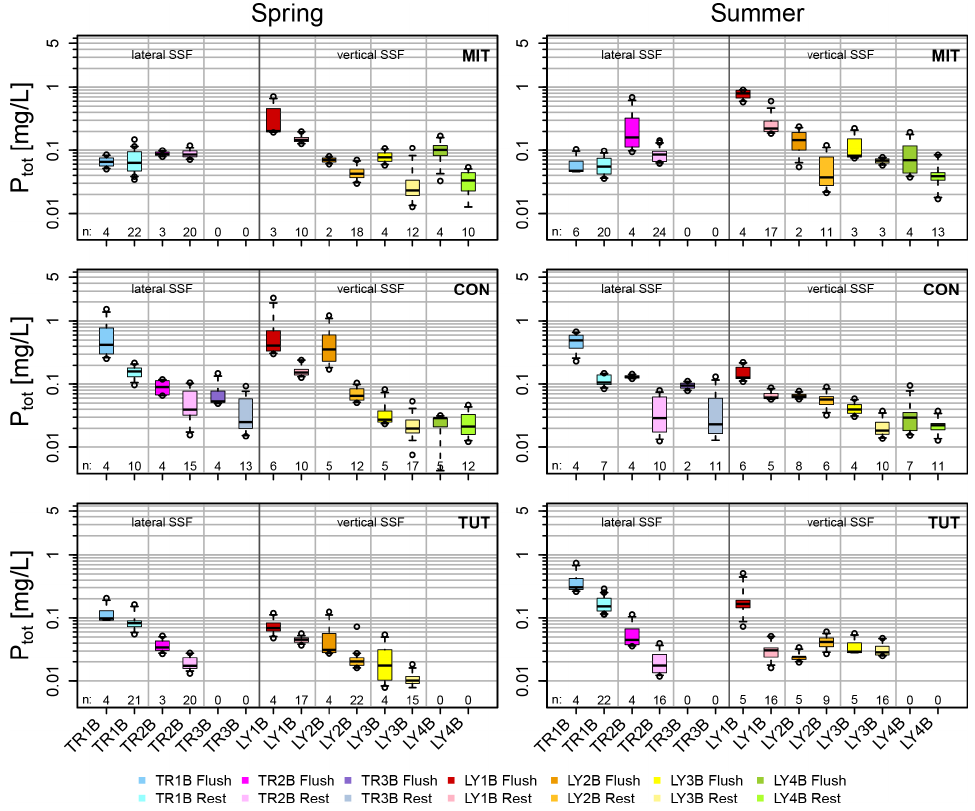
Figure 5. P tot concentrations of vertical and lateral subsurface flow (SSF) during the flushing period defined as the first 2h after the onset of each flow component (in darker colors) and the remaining part of the event (10 to 12h; in lighter colors) for the sprinkling experiments in Mitterfels (MIT), Conventwald (CON) and Tuttlingen (TUT). Table 6. Slope of the linear regression between P tot concentration and fraction of event water for the lysimeters (LYs) and the trenches (TRs) and for all sprinkling experiments in Mitterfels (MIT), Conventwald (CON) and Tuttlingen (TUT). Bold values are not significantly different from a slope equal to zero, and therefore the relation is likely chemostatic ( α = 0.05). Italic values indicate slopes that are not chemostatic and not significantly different from slopes describing simple dilution. Therefore, these relations are likely governed by proportional mixing. The × indicates that this LY or TR did not exist (TUT), and NA indicates that the trench yielded no flow (MIT). Event LY1B LY2B LY3B LY4B TR1B TR2B TR3B MIT spring − 0 .